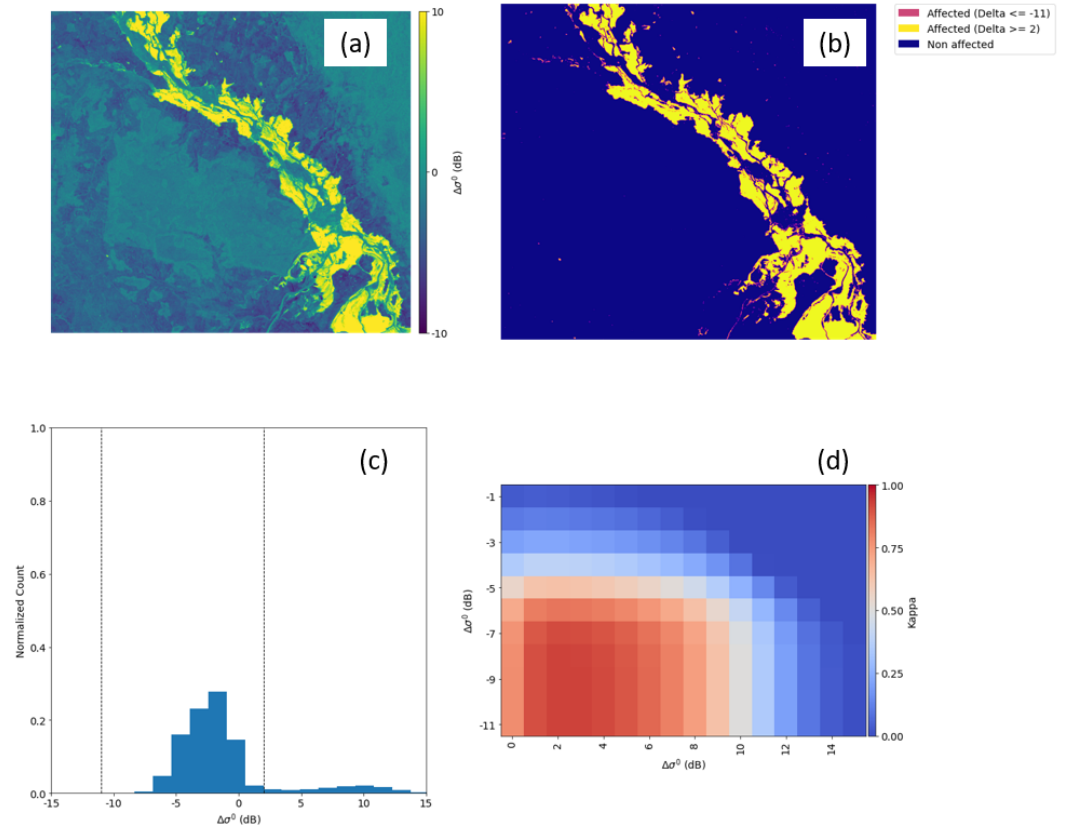
Figure 9. Australia ConvLSTM Delta image of VV polarization ( a ), Flood Proxy Map ( b ), Histogram of Delta image ( c ), and Cohen’s Kappa heatmap ( d